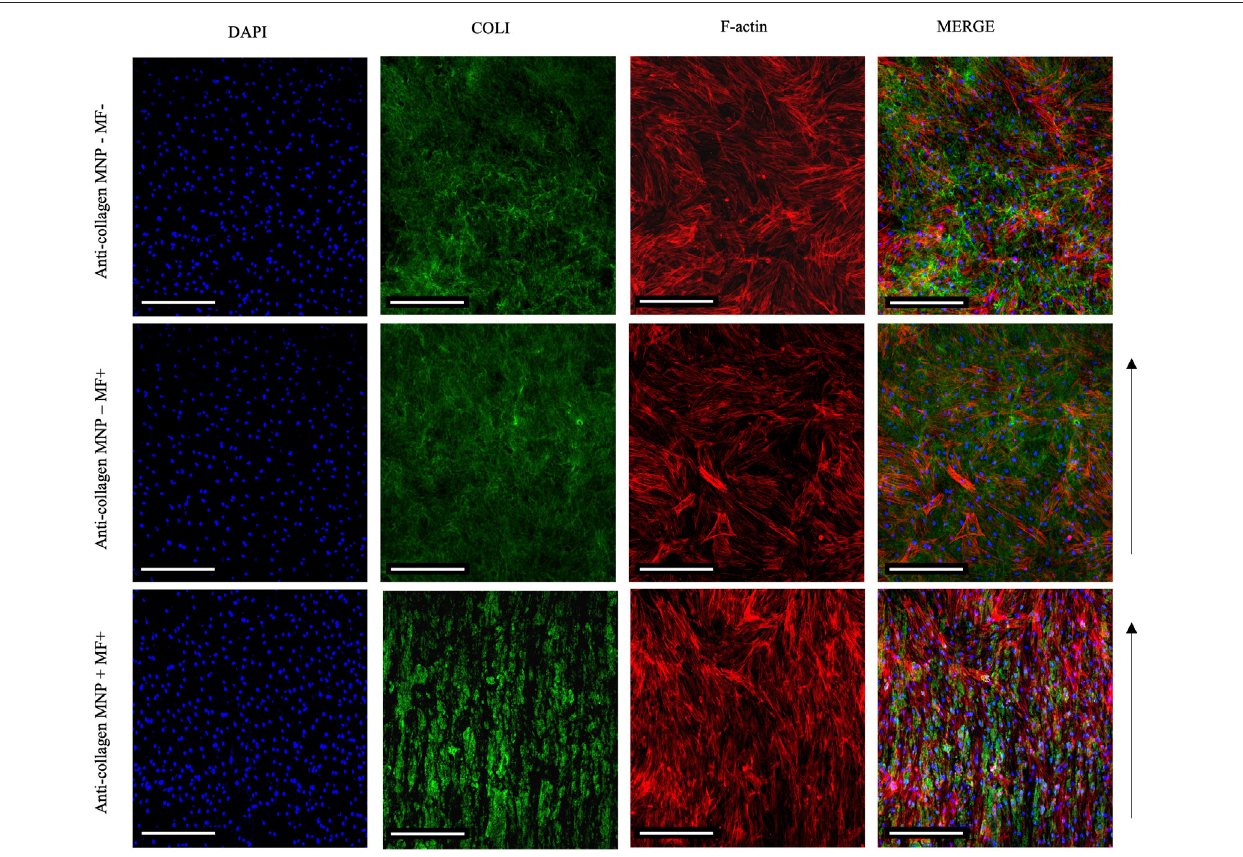
FIGURE 7 | Confocal imaging of primary hASCs seeded (250 cells/ul) within collagen hydrogels 7 days post-seeding. Merged images show an aligned arrangement of hASCs, in parallel to collagen fi ber-like structures in anti-collagen MNP-laden, magnetically aligned gels (bottom panel). Without MNP dosing and/or application of the magnetic fi eld, f-actin orientation can be observed to be poly-directional (top and middle panels). Scale bar = 200 μ m, magni fi cation = ×10, blue = nuclei, red = F-actin, green = collagen I, arrow = direction of magnetic fi eld lines, and n =